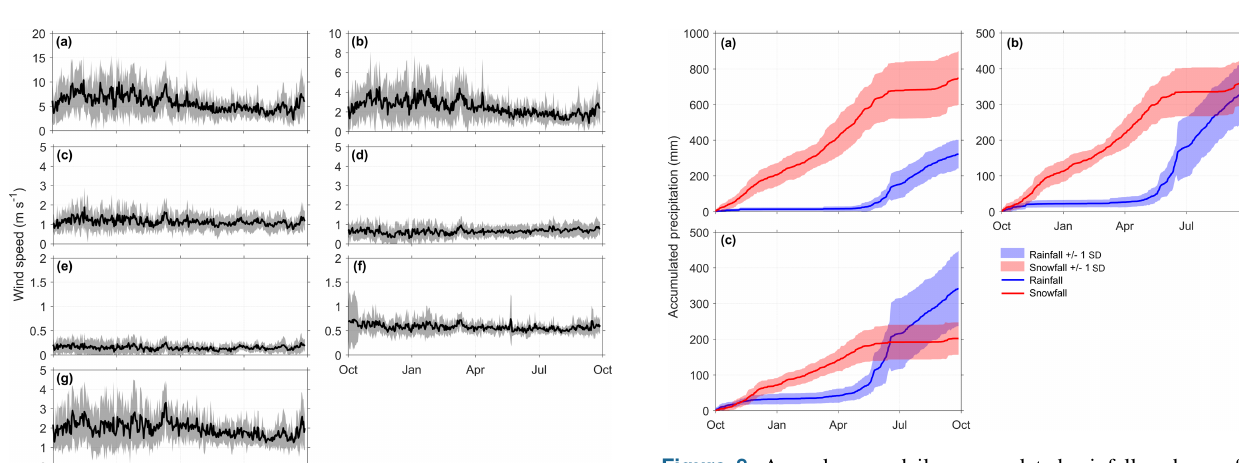
Figure 8. Annual mean daily accumulated rainfall and snowfall for 11 water years from 1 October 2005 to 30 September 2016 at MCRB stations: (a) Fisera Ridge, (b) Upper Clearing, and (c) Hay Meadow. The line represents the annual mean and the shaded area represents the standard deviation of the 11-year daily accumulated rainfall and snowfall. Rainfall and snowfall are calculated from wind-corrected storage-gauge observations with precipitation phase calculated as per Harder and Pomeroy